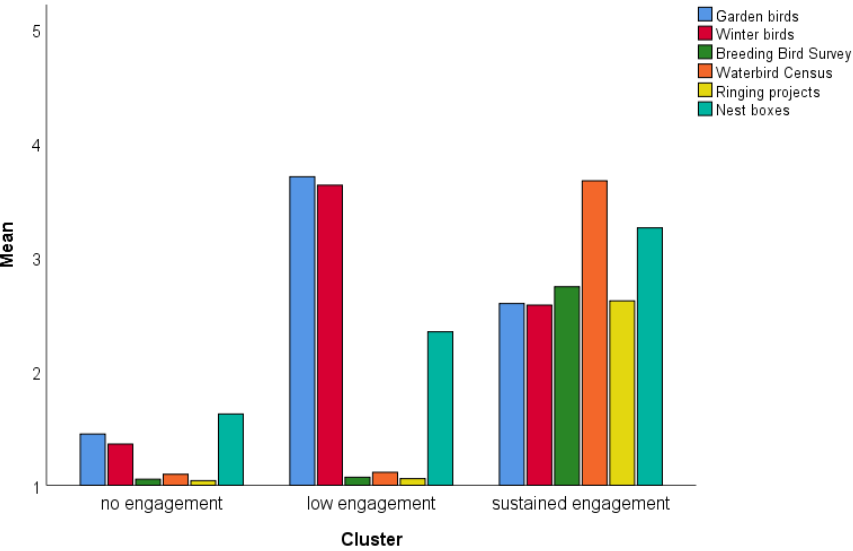
Figure 1. Results of the two-step cluster analysis. The y-axis shows the mean of the cluster for every variable. A high value represents a high engagement in the respective CS program.